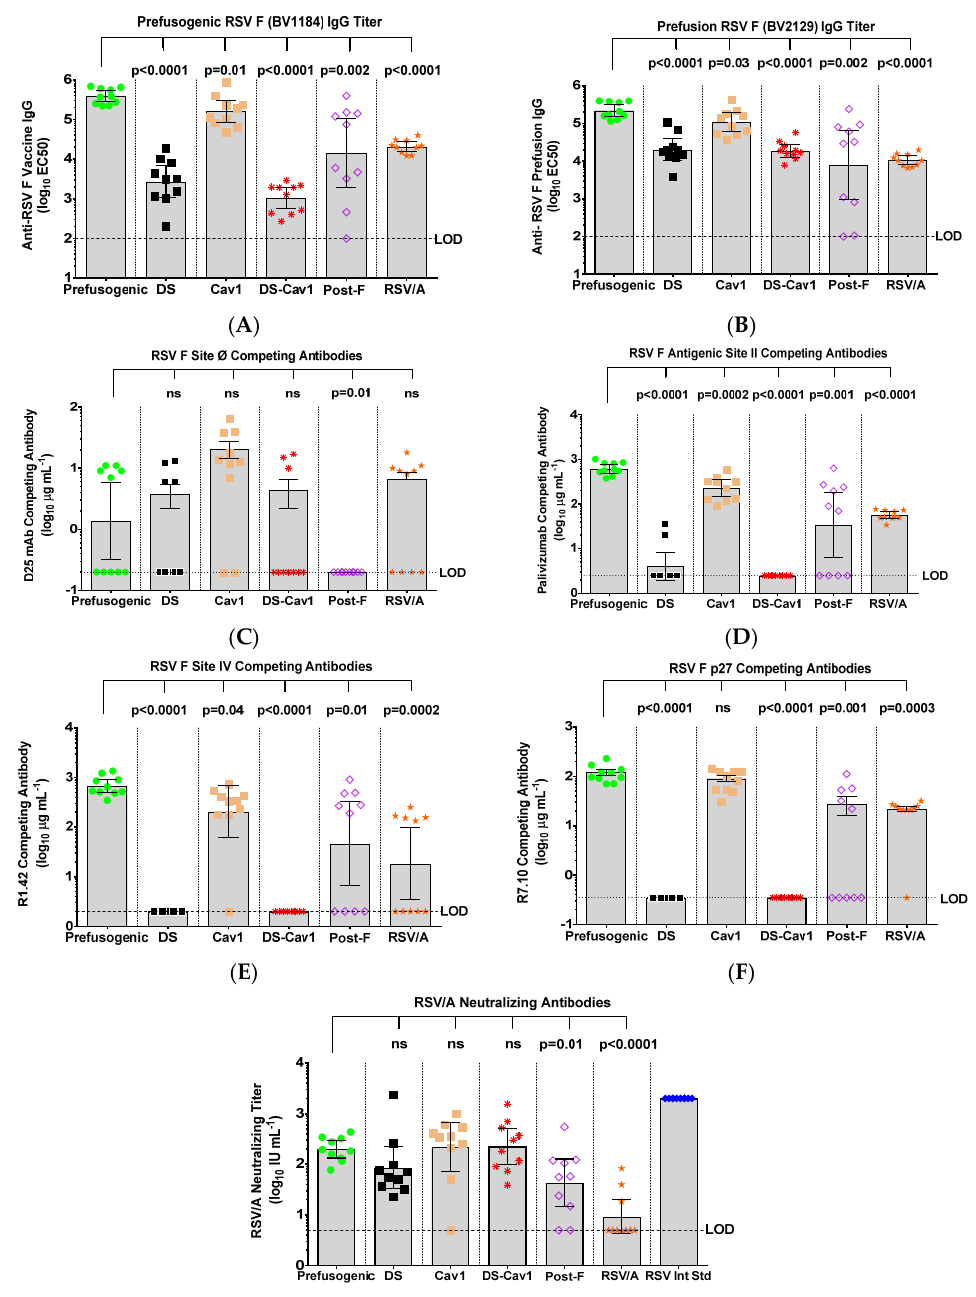
Figure 3. Immunogenicity of prefusogenic F and F variants in mice. Groups of mice were immunized by intramuscular injection with prefusogenic F vaccine (BV1184), DS (BV2267), Cav1 (BV2279), DS-Cav1 (BV2280) or postfusion F (BV2128) with 30 µg aluminum phosphate on days 0 and 21. A separate group (RSV/A) was challenged intranasal with 10 6 plaque forming units (pfu) RSV/A Long strain. Serum was collected for analysis from all animals on study day 35 (14-days after the second immunization). ( A ) Anti-prefusogenic F vaccine IgG (BV1184) and ( B ) anti-prefusion F IgG (BV2129) determined by ELISA. A competitive antibody ELISA was used to determine serum levels of antibodies that competed the binding of site-specific monoclonal antibodies (mAbs) ( C ) D25 (site Ø), ( D ) palivizumab (site II), ( E ) R1.42 (site IV), and ( F ) R7.10 (p27). ( G ) RSV neutralizing antibody titers were determined by